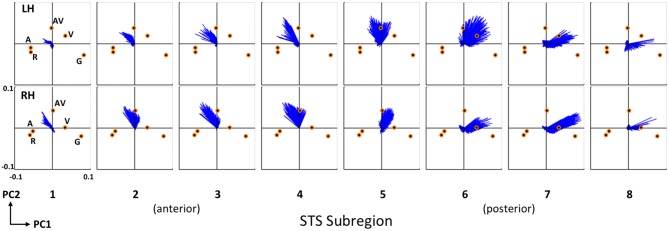
Condition preferences based on mean activity changes. Series of PCA biplots spanning all eight STS subregions are displayed for the right (top) and left (bottom) hemispheres. Each PCA biplot shows voxel coefficients as blue vectors, with orange circles representing the scaled principal component scores for each experimental condition. Conditions are labeled on the left-most plots for each hemisphere and these labels apply to the neighboring plots located to the right. On each plot, the first principal dimension is represented along the abscissa and the second principal dimension along the ordinate. The range of the axes (labeled on the bottom left plot) is identical for all 16 plots. Voxel coefficient vectors point toward the condition(s) preferred in terms of mean activity; shorter vectors correspond to voxels that did not exhibit a strong preference. These results clearly demonstrate a functional-anatomic gradient of activation preferences transitioning from visual (subregions 6–8) to audiovisual (subregions 4–5) to auditory (subregions 1–3) moving posterior to anterior.